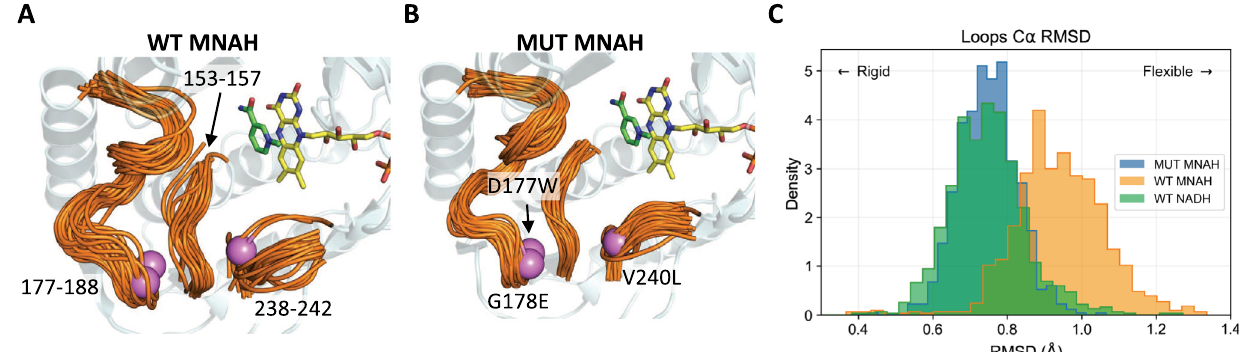
binding and catalysis. B Mut (LP 3-EP I158) with MNAH bound shows more tightly packed bundles for the overlaid structures, demonstrating greater rigidity com- pared to the WT. The addition of the large, hydrophobic substitutions crowds the AMP binding cleft and reduces the volume of space for the loops to explore alternative conformations. C Quanti fi cation of the loop fl exibility through alpha carbon RMSD illustrates that WT with MNAH exhibits higher loop fl exibility with